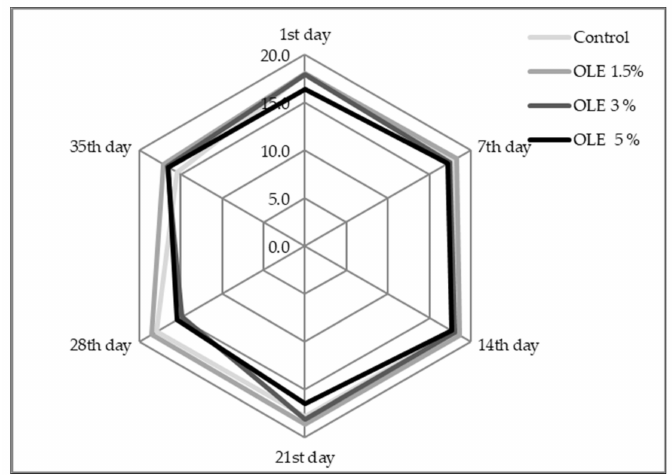
Figure 5. Total scores achieved by sensory evaluation of yoghurt samples without (control) and with the addition of olive leaf extract (OLE 1.5%, OLE 3%, and OLE 5%) during 35 days of cold storage. Significant differences ( p = 0.045) were detected in sensory-evaluated colour with respect to the addition of OLE between sample OLE 5% and all other samples, which corresponded to instrumental colour measurements (Table 2). Still, storage time did not show a significant influence ( p = 0.067) on this attribute (Table 5). Considering the